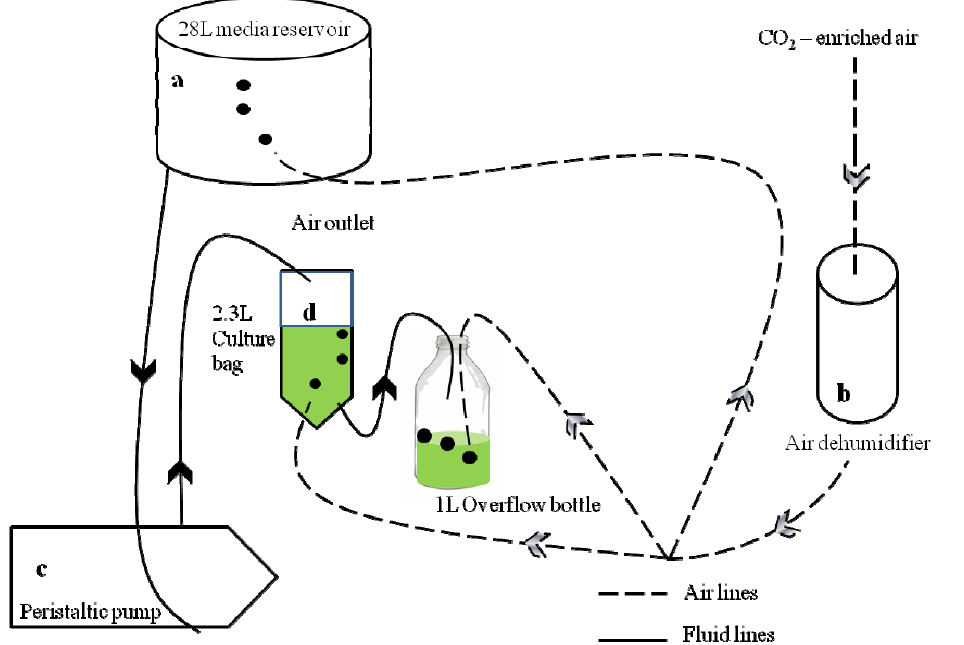
Figure 1. Overview schematic diagram of the ocean acidification continuous culture system. For simplicity only one CO treatment and culture bag is shown. ( a ) Eight 28 L 2 media reservoirs supplied the cultures with media of the respective p CO . The reservoirs 2 were continuously bubbled with CO -enriched air of the respective concentration; ( b ) Air 2 bubbling through the reservoirs and all culture bags and overflow bottles was first dehumidified by passing through a silica-gel filled cylinder fitted with an activated charcoal stage at the end to remove any organic contaminants; ( c ) Peristaltic pumps delivered the media from the reservoirs to each culture bag at a rate equivalent to the growth rate of the culture; ( d ) Culture bags and overflow bottles were continuously bubbled to maintain stable carbonate chemistry. At the same rate as media was pumped in, culture overflowed into a sterile overflow bottle, which was sampled for subsequent biochemical and other